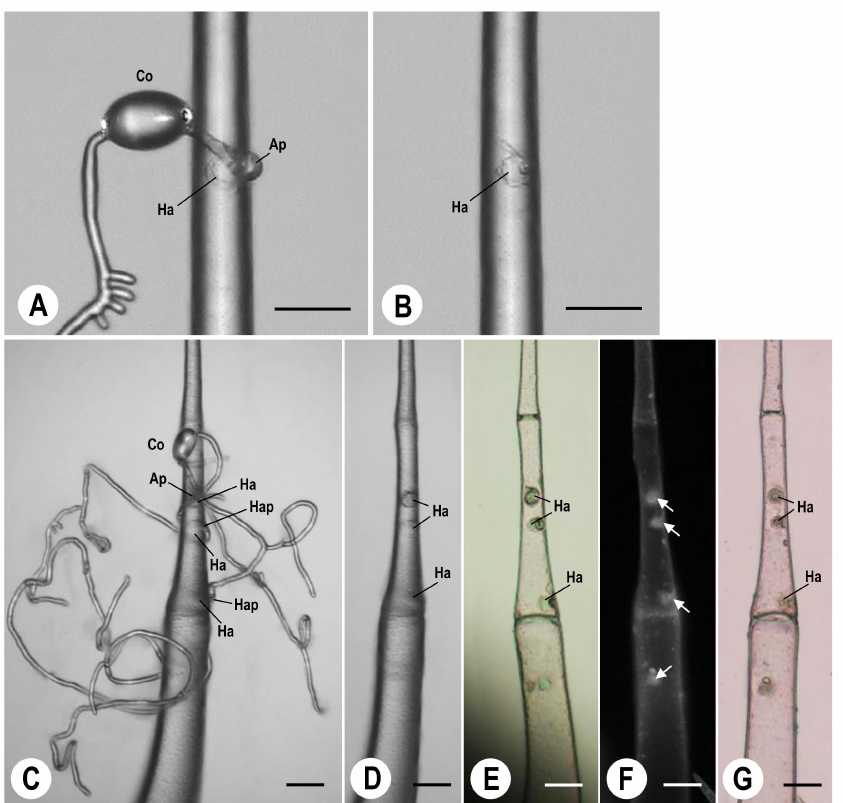
Figure 3. Digital ( A – D ), light and epifluorescent ( E , F ), and light ( G ) micrographs showing haustoria of KTP-03 and papilla-like structures in leaf type I trichome cells of tomato cv. Moneymaker (MM) in the same field of view. ( A , C ) KTP-03 conidium (Co) formed one haustorium (Ha) beneath the primary appressorium (Ap) ( A ) and 3–4 haustoria (Ha) beneath the primary appressorium (Ap) and hyphal appressoria (Hap) on the trichome cells ( C ). ( B , D ) One ( B ) and three haustoria ( D ) located in a trichome cell after the removal of KTP-03 hyphae from the trichome cells shown in ( A , C ) (at 2 days and 7 days after inoculation of KTP-03 conidia), respectively, using a small glass needle. ( E , F ) Without chemical treatment, haustoria (Ha) exhibited spherical structures ( E ) and papilla-like structures (white one-sided arrows) fluoresced in a single trichome cell ( F ). ( G ) With chemical treatment, haustoria (Ha) were stained light brown. Micrographs were acquired at 2 days ( A ) and 7 days ( C ) and after inoculation with KTP-03 conidia. Bars indicate 20 µ